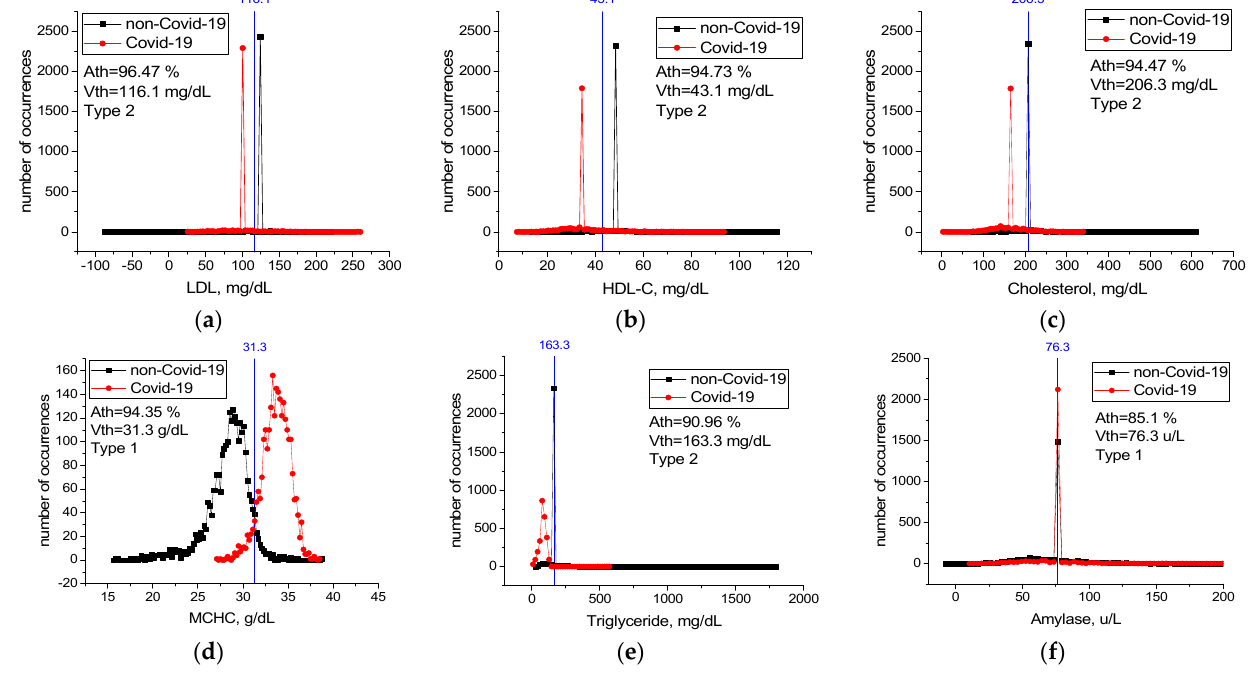
Figure 6. Case distribution histograms for LDL ( a ), HDL ‐ C ( b ), Cholesterol ( c ), MCHC ( d ), Triglyceride ( e ), Amylase ( f ) from sick and healthy individuals and the threshold values Vth of these features (blue line) in the diagnosis of the disease. Histogram bin sizes are listed in Table A1. For features from Table 6 not included in Figure 6, case distribution histograms (MCH, aPTT, HCT, MONO, RBC) are demonstrated in Figure 7. The success of these fea ‐ tures alone in detecting sick and healthy individuals was less than 60% (Figure 7). How ‐ ever, the combination of MCHC with MCH and the combination of MCHC with HDL ‐ C in detecting sick and healthy individuals is higher than their individual performance (Table 7). Revealed high ‐ level mutual information among these variables helps LogNNet to diagnose COVID ‐ 19. The combinations of MCH, aPTT, HCT, MONO, and RBC fea ‐ tures are not effective in the diagnosis of the disease ( A 5 ( FS [10,17,19,22,25]), Table 7). We think that there is a low correlation between these features and COVID ‐ 19.